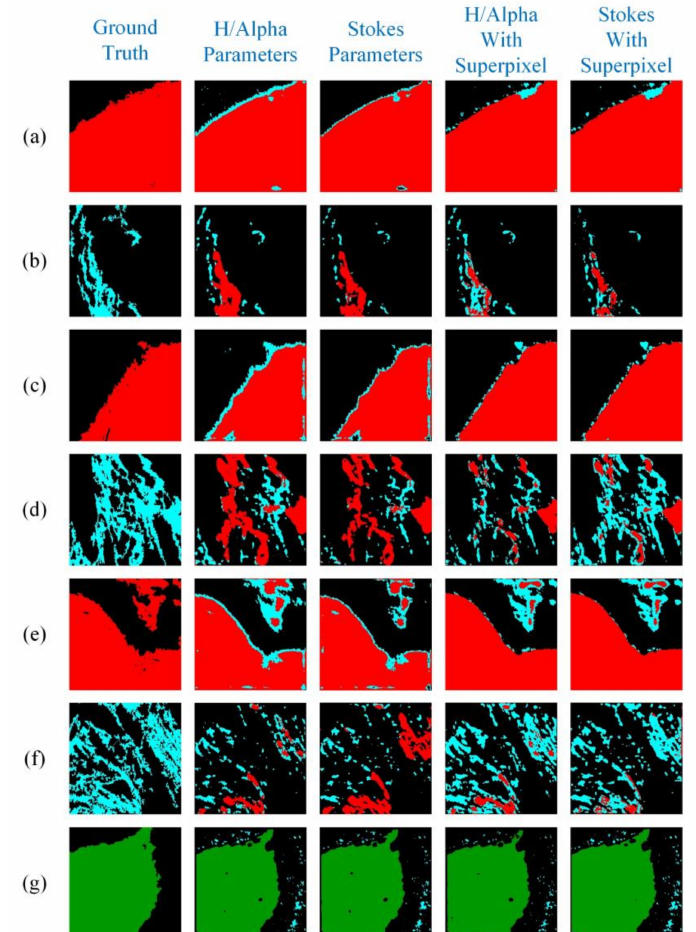
Figure 9. Classification results of some typical samples using polarized parameters and SLIC super- pixels. Red represents oil spill, blue represents look alike, while green represents land areas. ( a ) oil spill, ( b ) look alike, ( c ) oil spill, ( d ) look alike, ( e ) oil spill, ( f ) look alike, ( g )